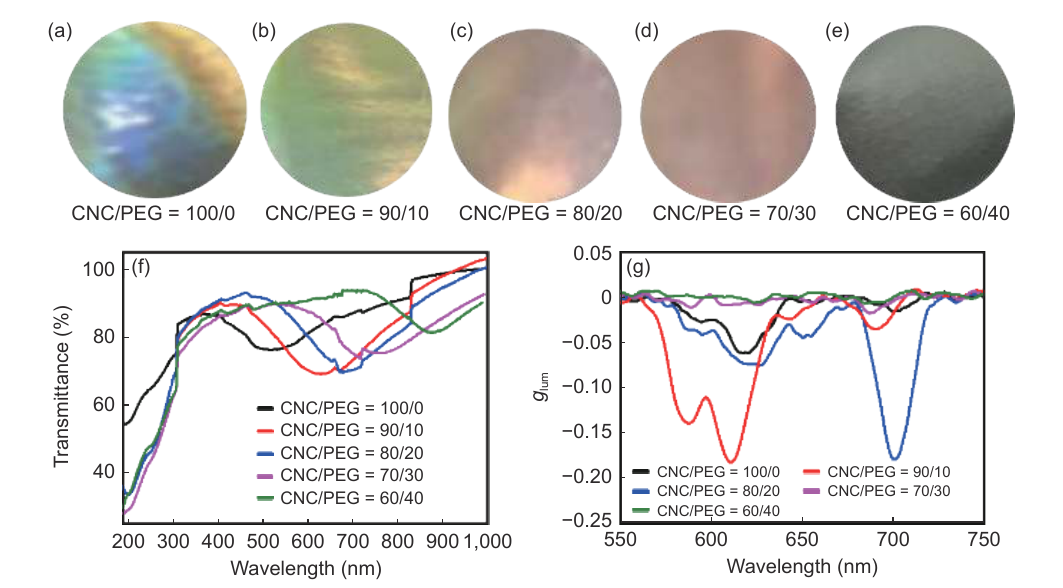
Figure 5 The pictures of CNC/PEG/EuW 10 composite films at RH ~ 100%: (a) CNC/PEG = 100/0; (b)CNC/PEG = 90/10; (c) CNC/PEG = 80/20; (d) CNC/PEG = 70/30; (e) CNC/PEG = 60/40. (f) Transmission spectra and (g) CPL spectra of CNC/PEG/EuW 10 composite films at RH = 100%.